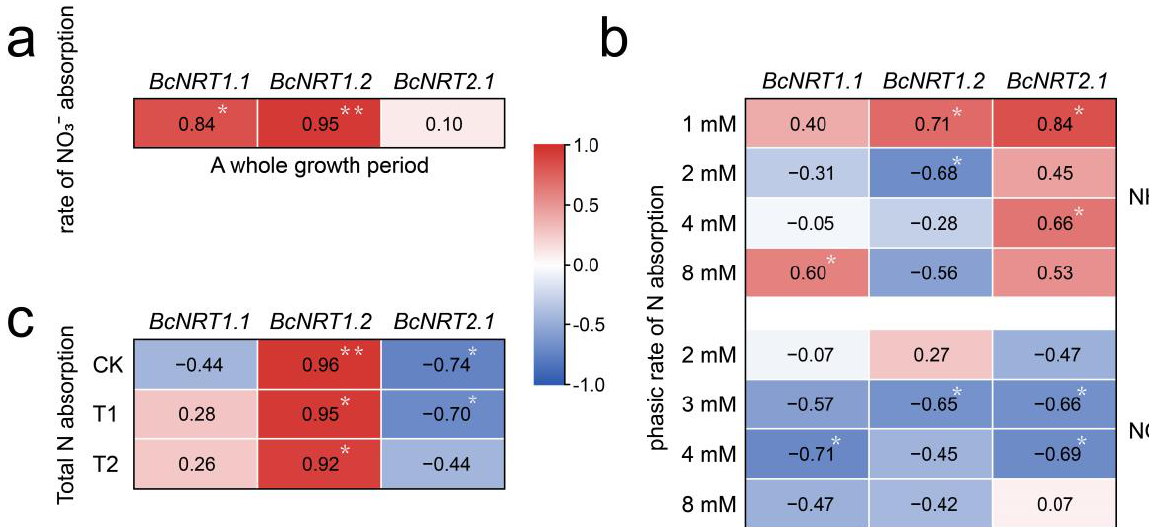
Figure 5. Correlation analysis between N absorption and BcNRT genes expression in flowering Chinese cabbage. ( a ) Correlation analysis between NO 3 − absorption rate and BcNRT genes. ( b ) Correlation between phasic N uptake rate and BcNRT genes expression under different concentrations of N sources. ( c ) Correlation between total N uptake and BcNRT genes expression under different NH 4+ /NO 3 − ratios. Red: Positive correlation; blue: negative correlation; white: no correlation. White asterisks indicate significance (*: p < 0.05, **: p < 0.01).